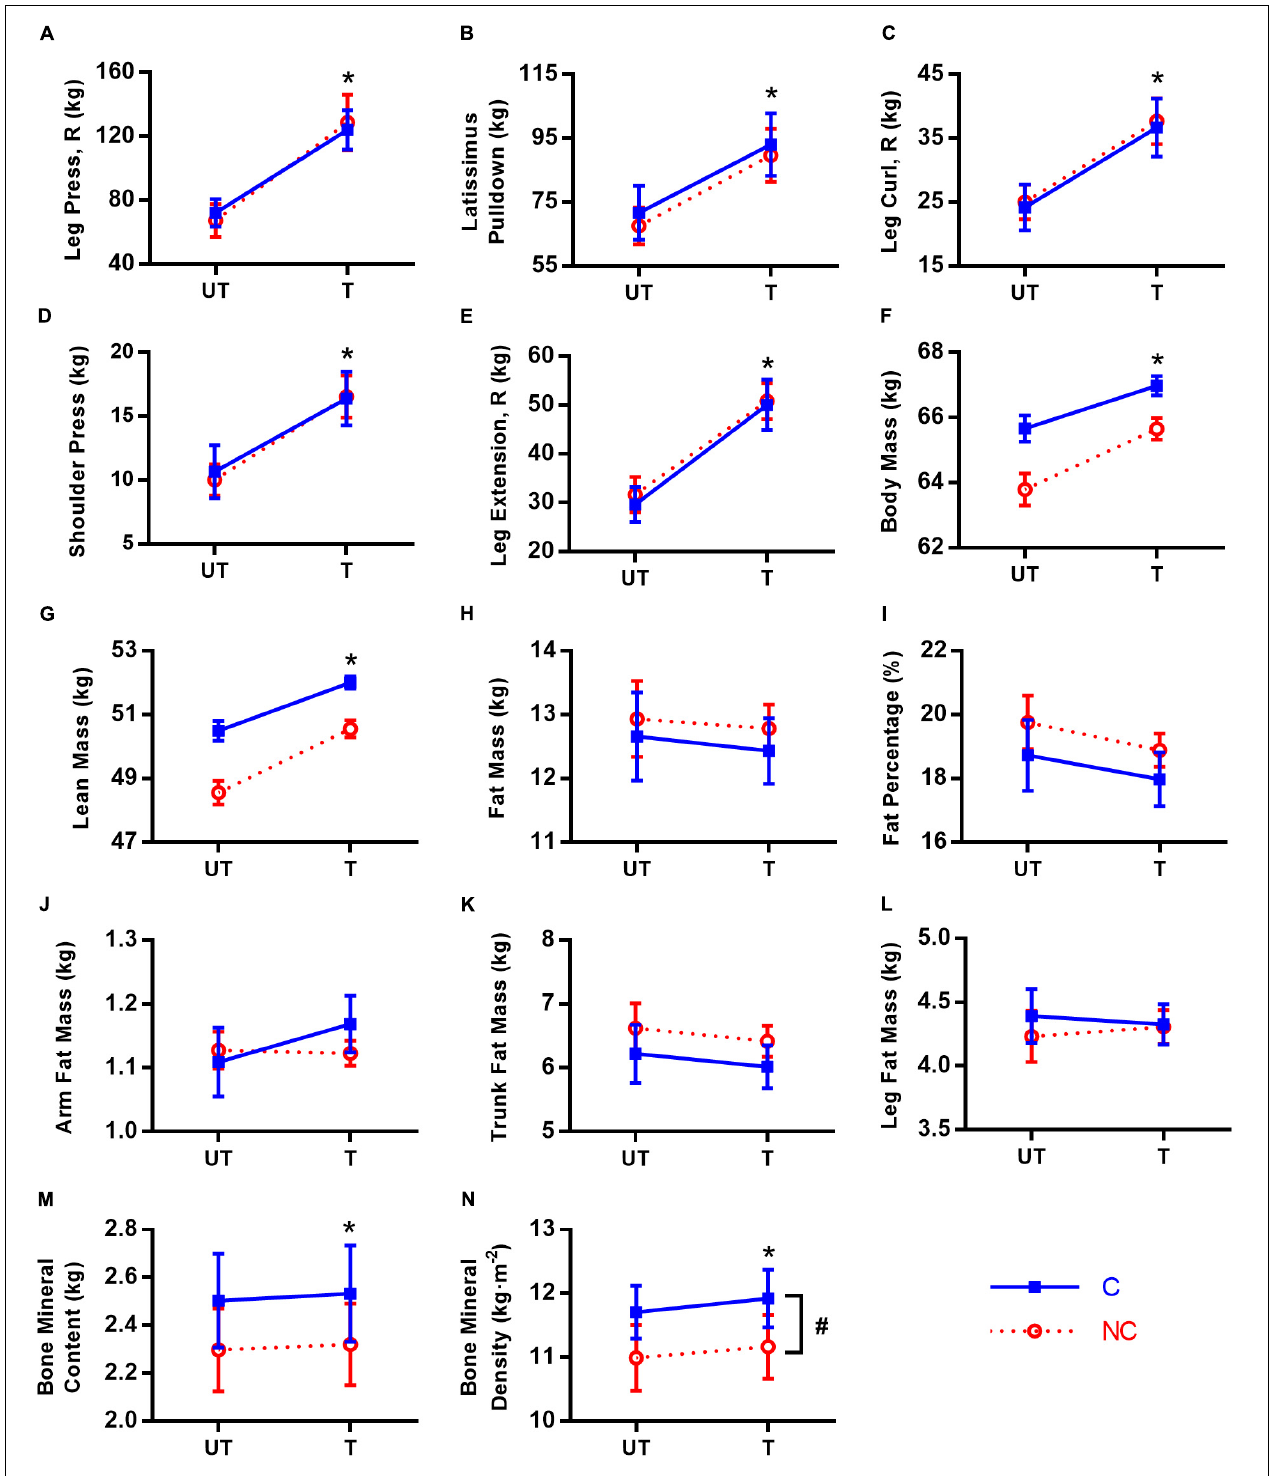
FIGURE 2 | Ten-repetition maximum and body composition in untrained (UT) and trained (T) states for consecutive (C, (cid:4) ) and non-consecutive (NC, ◦ ) groups for: leg press with right leg (A) , latissimus pulldown (B) , leg curl with right leg (C) , shoulder press (D) , leg extension with right leg (E) , body mass (F) , lean mass (G) , fat mass (H) , fat percentage (I) , arm fat mass (J) , trunk fat mass (K) , leg fat mass (L) , bone mineral content (M) , and bone mineral density (N) . Values are means with 95% confidence interval. For (F–L) , means are calculated from predicted values after adjustment for covariates. No significant training × group interaction for all parameters ( p = 0.075–0.974). ∗ Significant difference between UT and T states ( p < 0.001). # Significant group difference between C and NC ( p = 0.025).